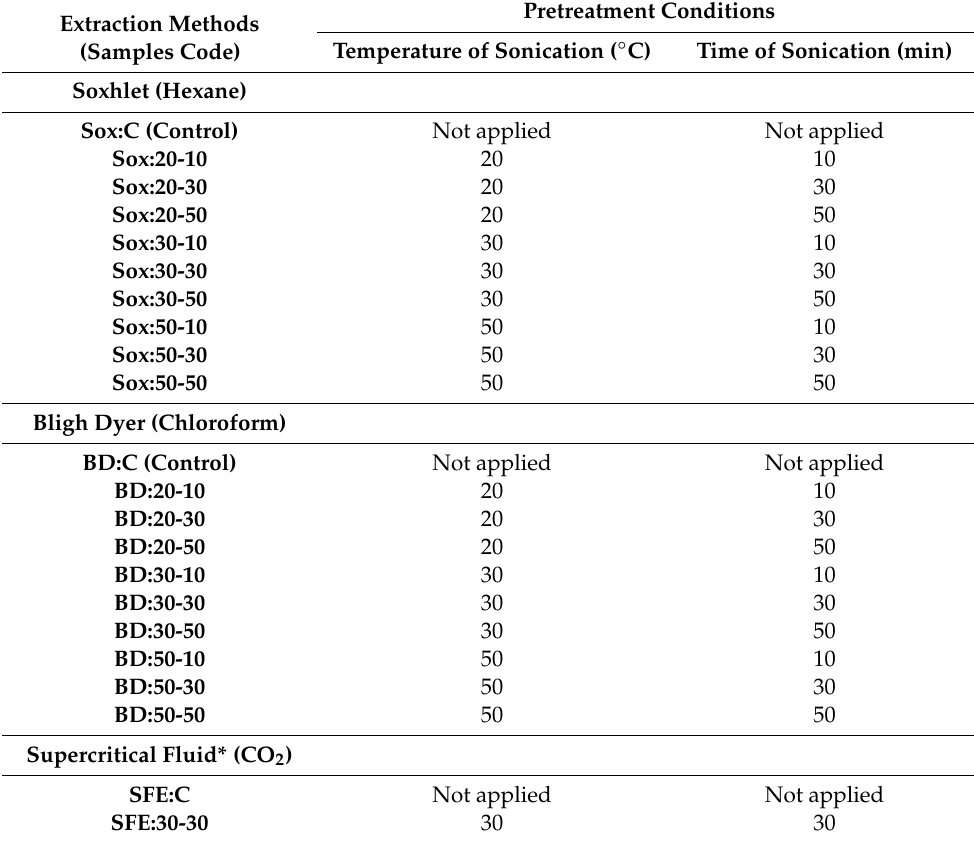
Table 5. Experimental parameters employed for the pretreatment of grape seed samples (var. Syrah) with ultrasound (frequency 50–60 Hz), extraction methods investigated for each condition and obtaining